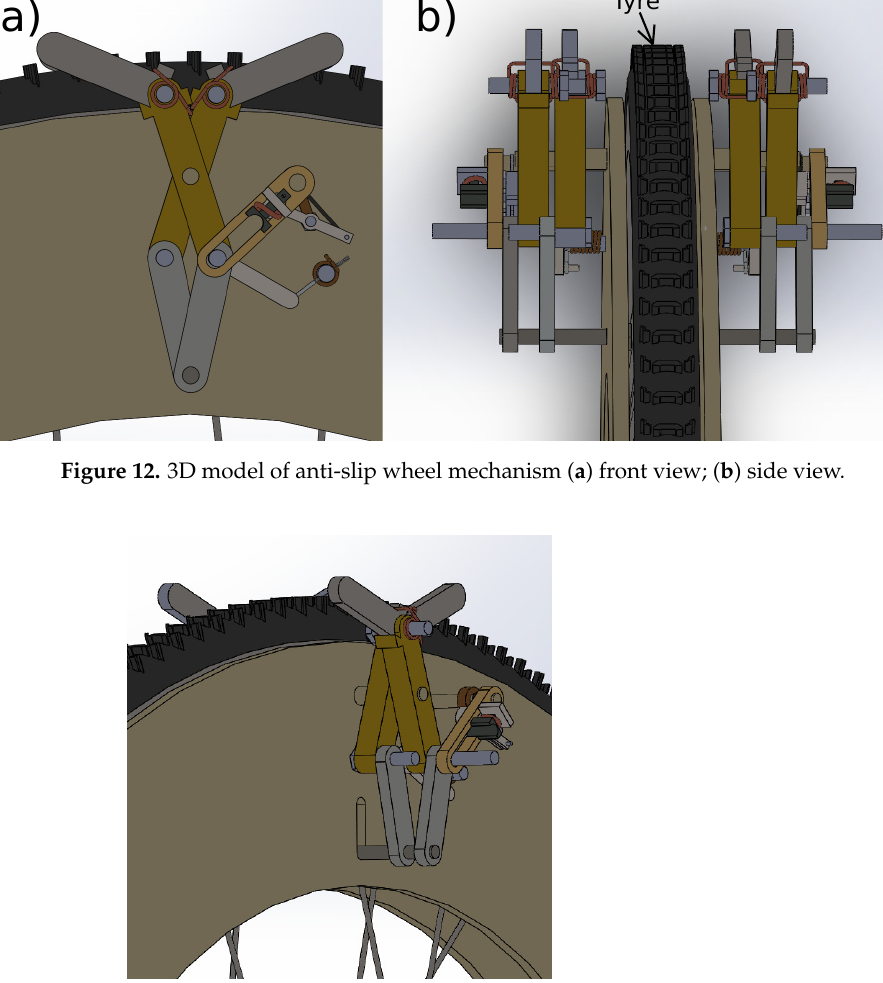
Figure 13. Perspective view of the 3D model of the anti-slip wheel